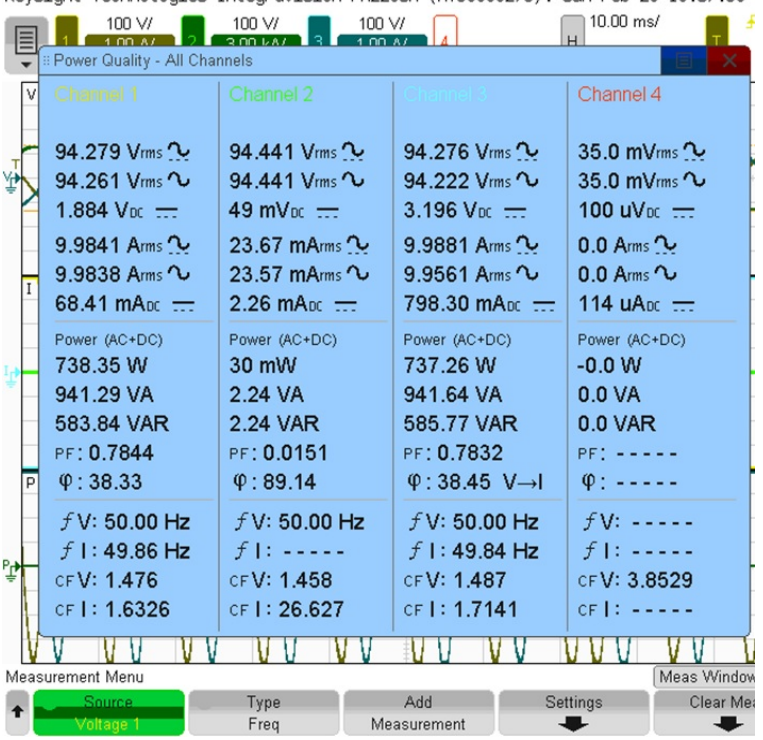
Figure 12. Voltage sag conditions in grid connected to induction motor under loaded conditions.